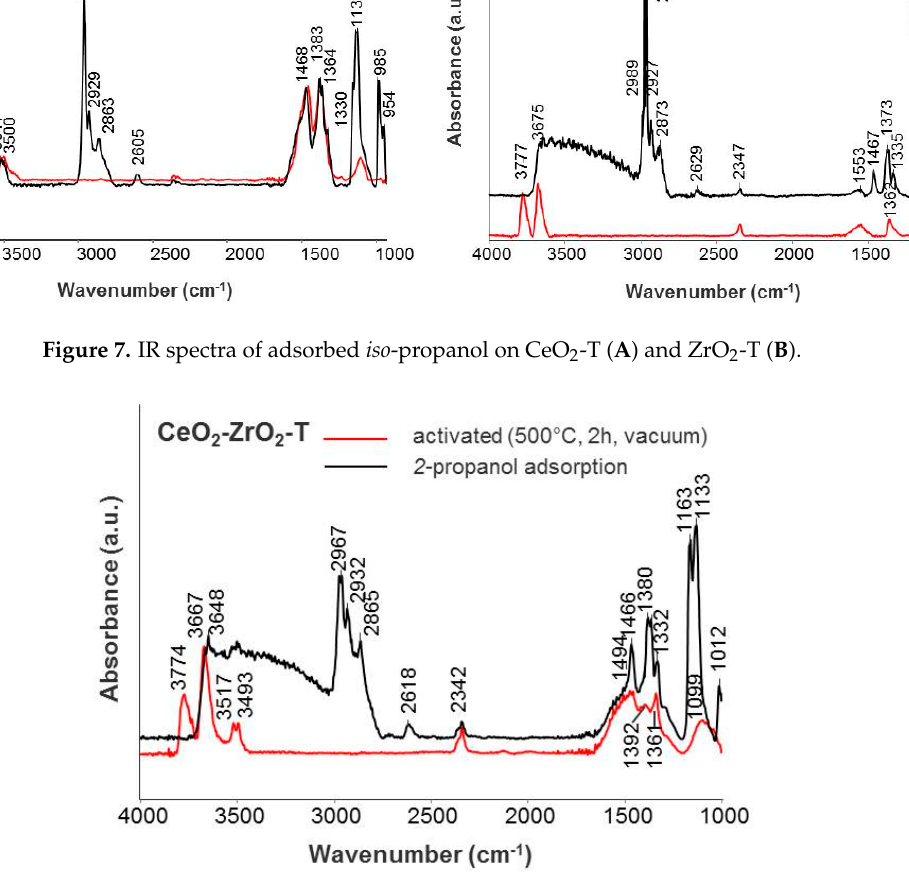
Figure 8. IR spectra of adsorbed iso -propanol on CeO 2 –ZrO 2 -T.